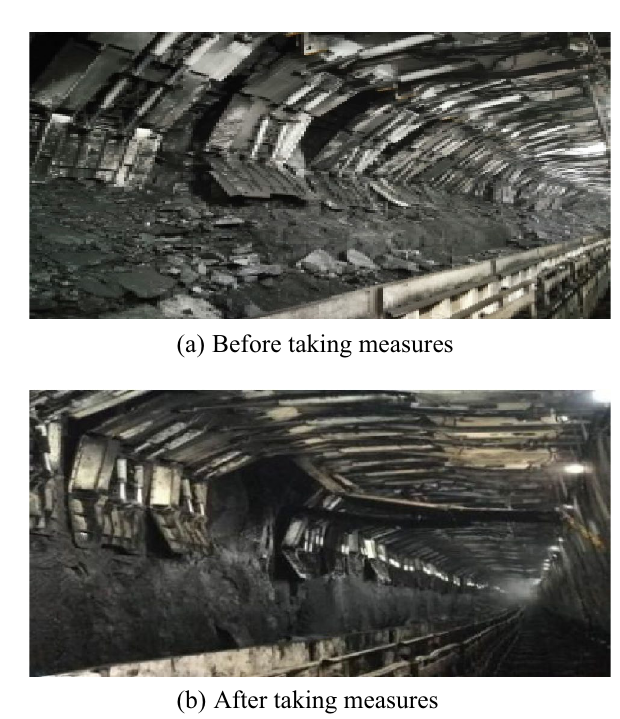
Fig. 13 12,401 seam working conditions before and after taking